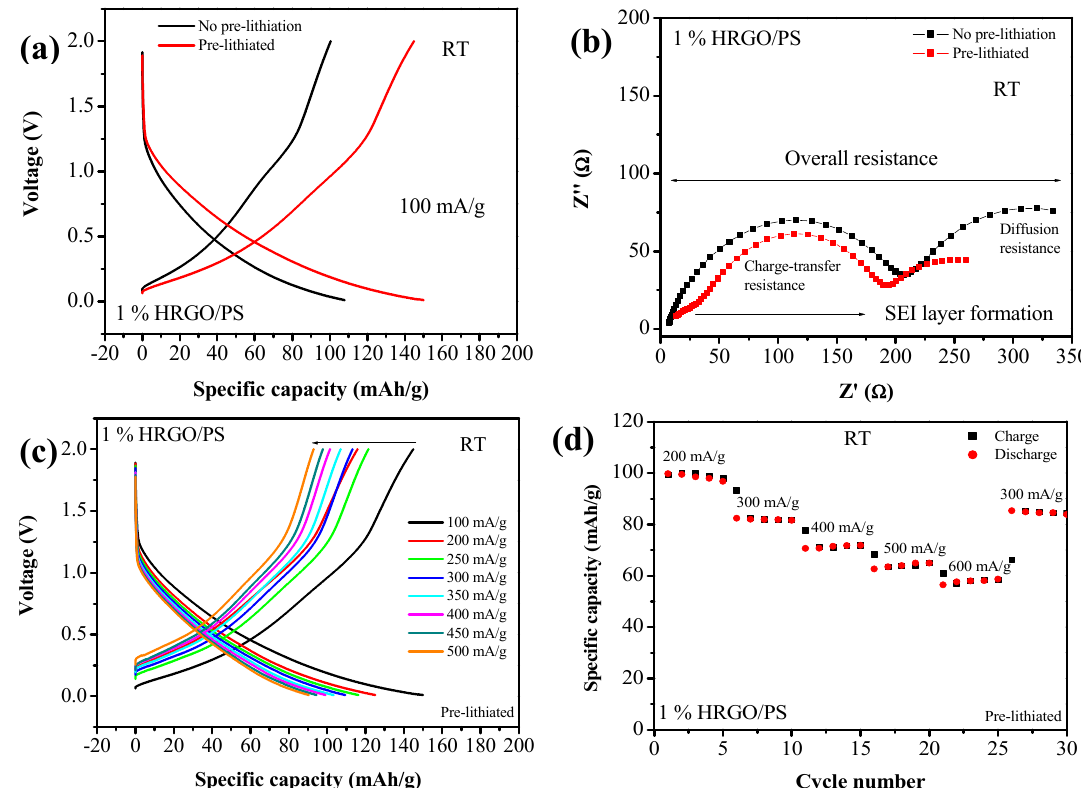
Figure 8. ( a ) Galvanostatic charge / discharge curves for non-pre-lithiated and pre-lithiated 1% HRGO / PS electrode for one cycle obtained at a current density of 100 mA / g, ( b ) Nyquist plot for non-pre-lithiated and pre-lithiated 1% HRGO / PS electrodes, and ( c ) and ( d ) rate capabilities of pre-lithiated 1% HRGO / PS at various current densities.